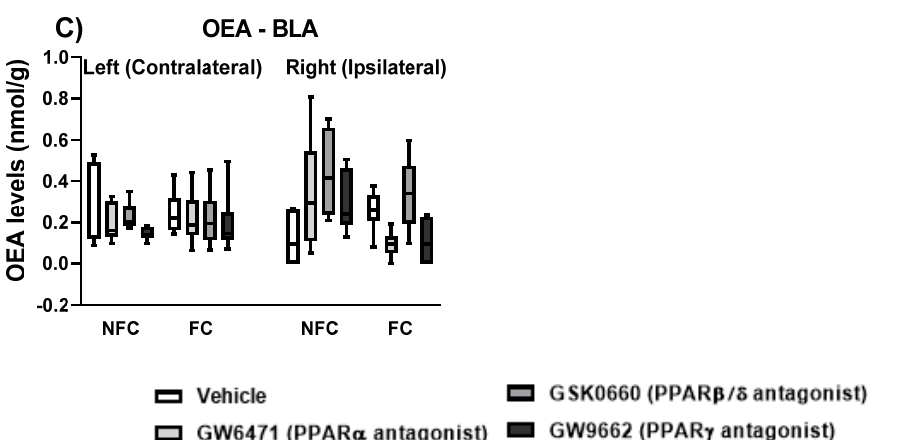
Figure 14 . Effects of fear-conditioning and intra-BLA administration of selective PPAR α , PPAR β / δ , and PPAR γ antagonists on the levels of, PEA ( A ), AEA ( B ), and OEA ( C ). Post hoc analysis with Dunn’s test indicated that FC GW6471-treated rats had decreased levels of PEA compared to the FC Vehicle treated rats in the right BLA ( $ p < 0.05). Data are expressed as median with interquartile range and min/max ( n = 6–9 rats per group).